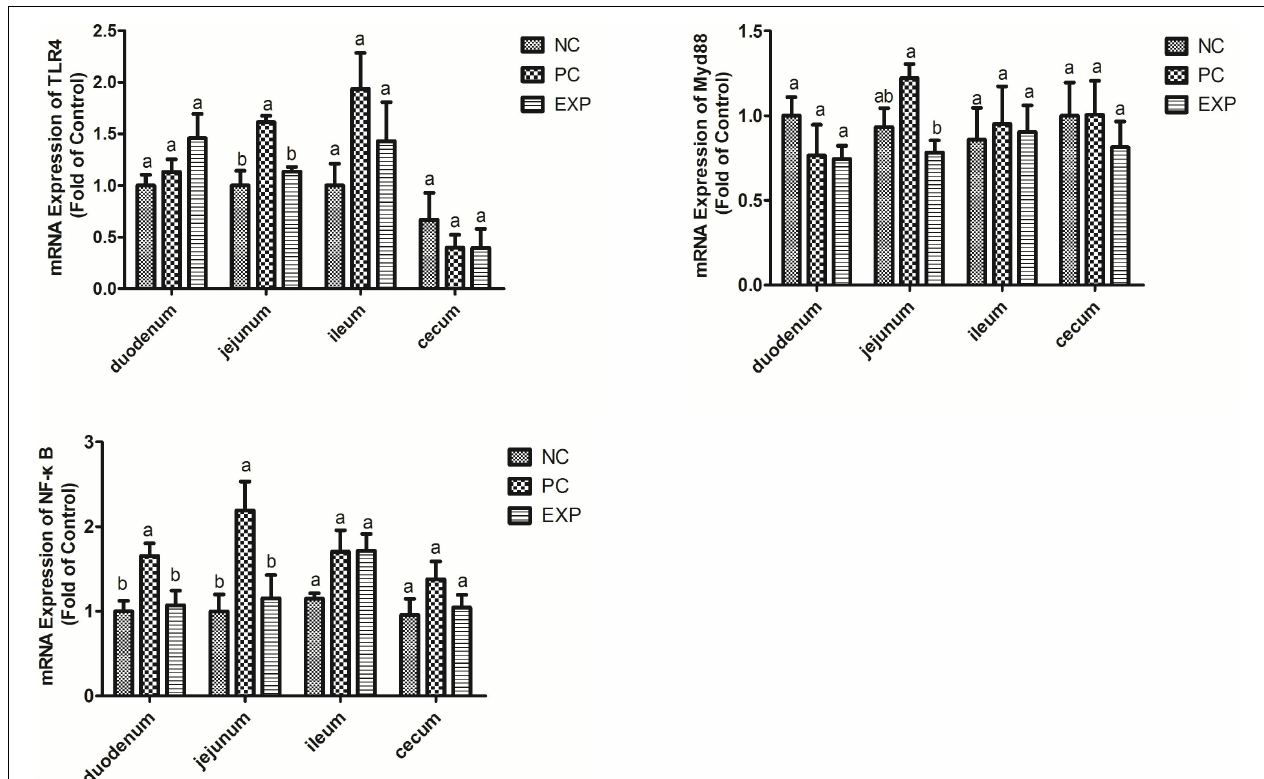
FIGURE 4 | Clostridium butyricum supressed inflammation via TLR4-, MyD88-, and NF- κ B-dependent pathways. Relative mRNA expression of TLR4, MyD88, and NF- κ B in the intestine tissues (duodenum, jejunum, ileum, and cecum) were estimated by real-time PCR. The bars represent the mean ± SD ( n = 6/group). Different letters over the bars indicate statistically differences between the groups ( P < 0.05), same letters over the bars indicate no statistically differences between the groups ( P > 0.05). NC, the negative control group; PC, the positive control group; EXP, C. butyricum + S. enteritidis treatment.